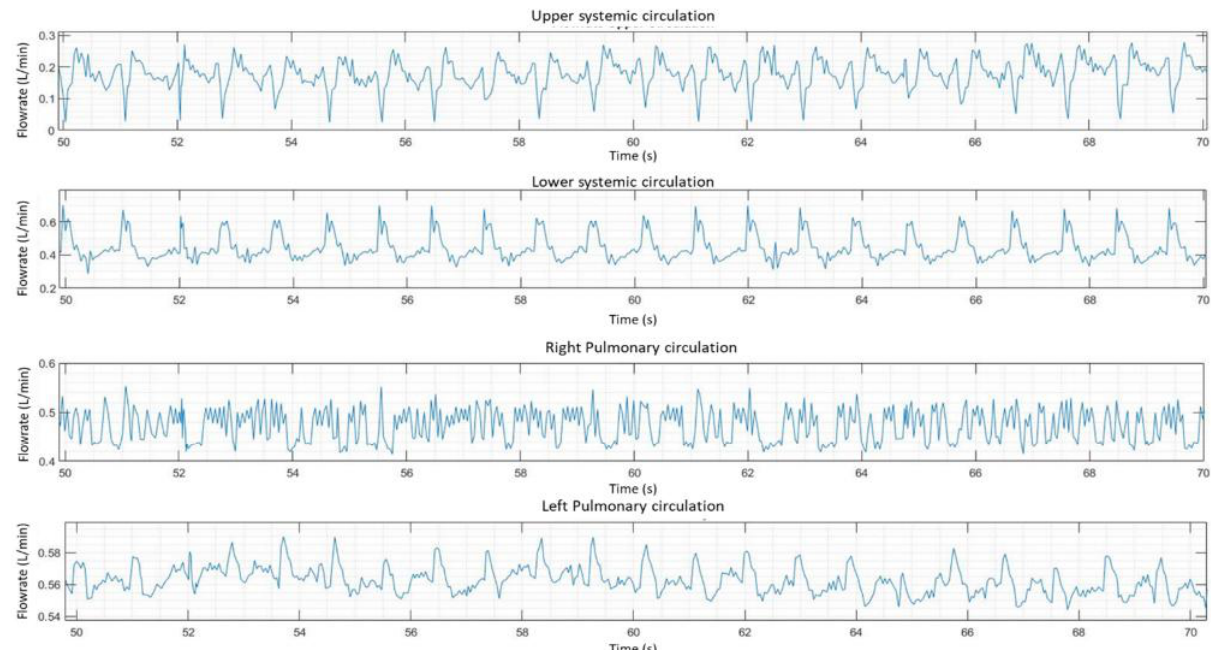
Figure 13. Unfiltered Flow waveform for 3 mm IJS with 5 degree anastomosis angle experiment.